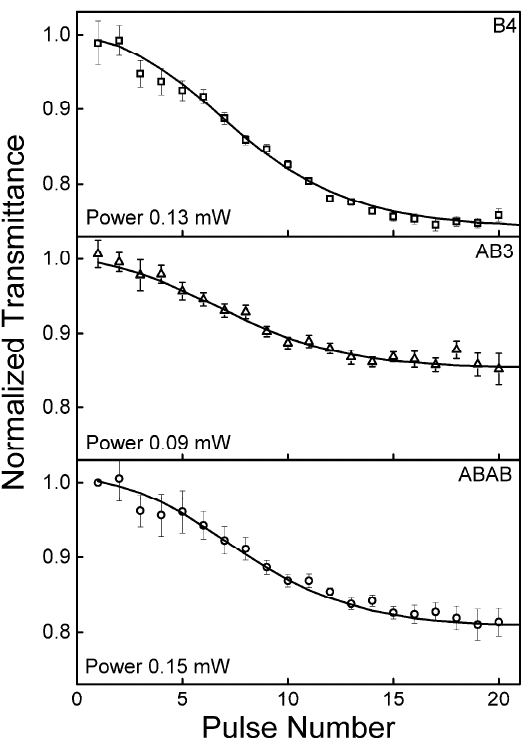
Figure 7. Experimental normalized transmittance (symbols) along the pulse train for B4 , AB3 and ABAB dissolved in chloroform measured at 532 nm. The solid lines represent the best fits obtained with the rate equation described by Equation (3).